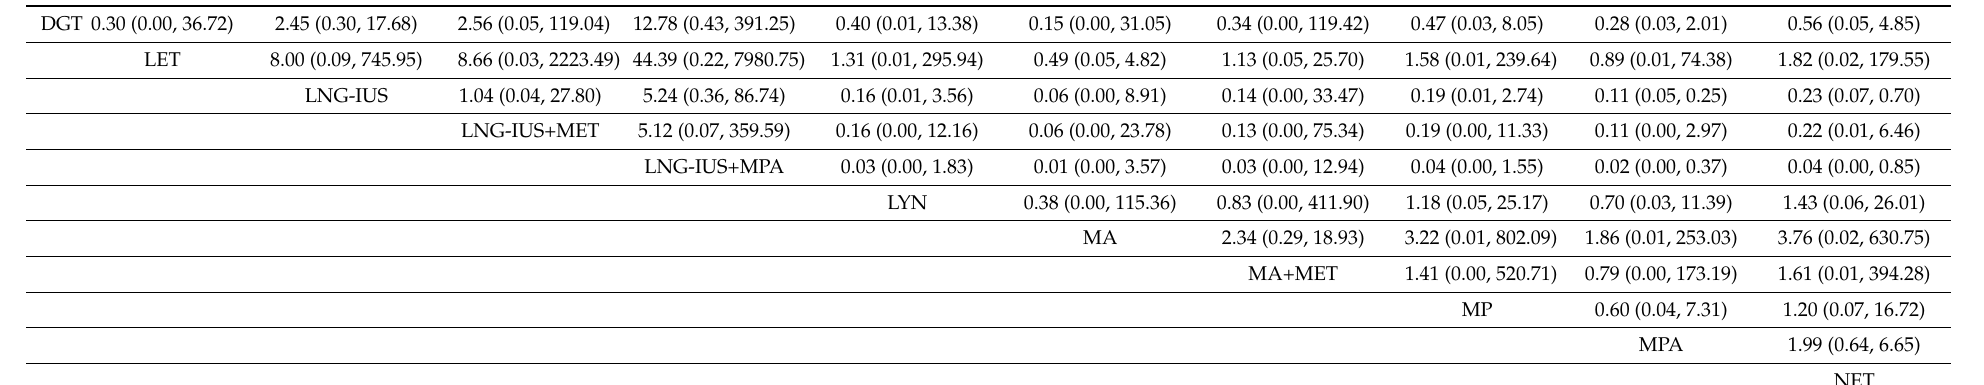
Table 2. Network meta-analysis of regression rates in patients with endometrial hyperplasia after the indicated